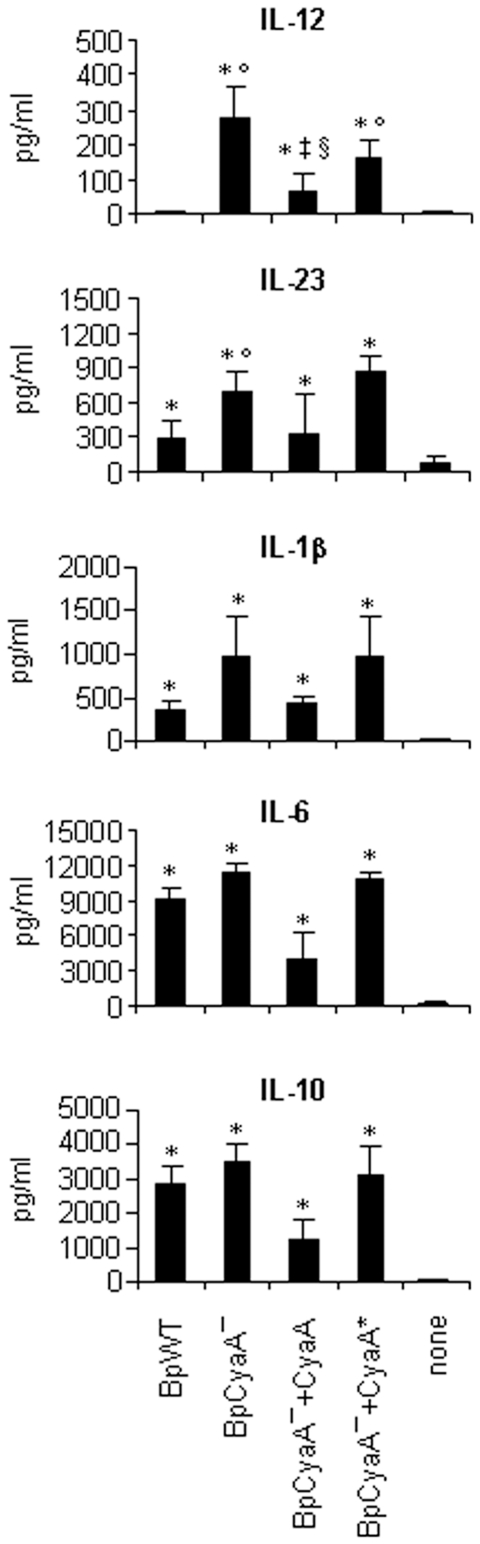
Cytokine production.MDDC were either untreated (none) or treated with BpWT or BpCyaA−, the latter in the presence or absence of CyaA and CyaA* (50 ng/ml ) for 48 h. IL-12p70, IL-23, IL-1β, IL-6 and IL-10 were assessed by ELISA. Values are expressed as mean ± SE from nineteen (IL-12p70), eleven (IL-10), six (IL-23, IL-1β and IL-6) independent experiments performed with MDDC obtained from different donors, and expressed as pg/ml of cytokine released. * p<0.05 vs none; °p<0.05 vs BpWT; ‡
p<0.05 vs BpCyaA−; §
p<0.05 vs BpCyaA−+CyaA*.